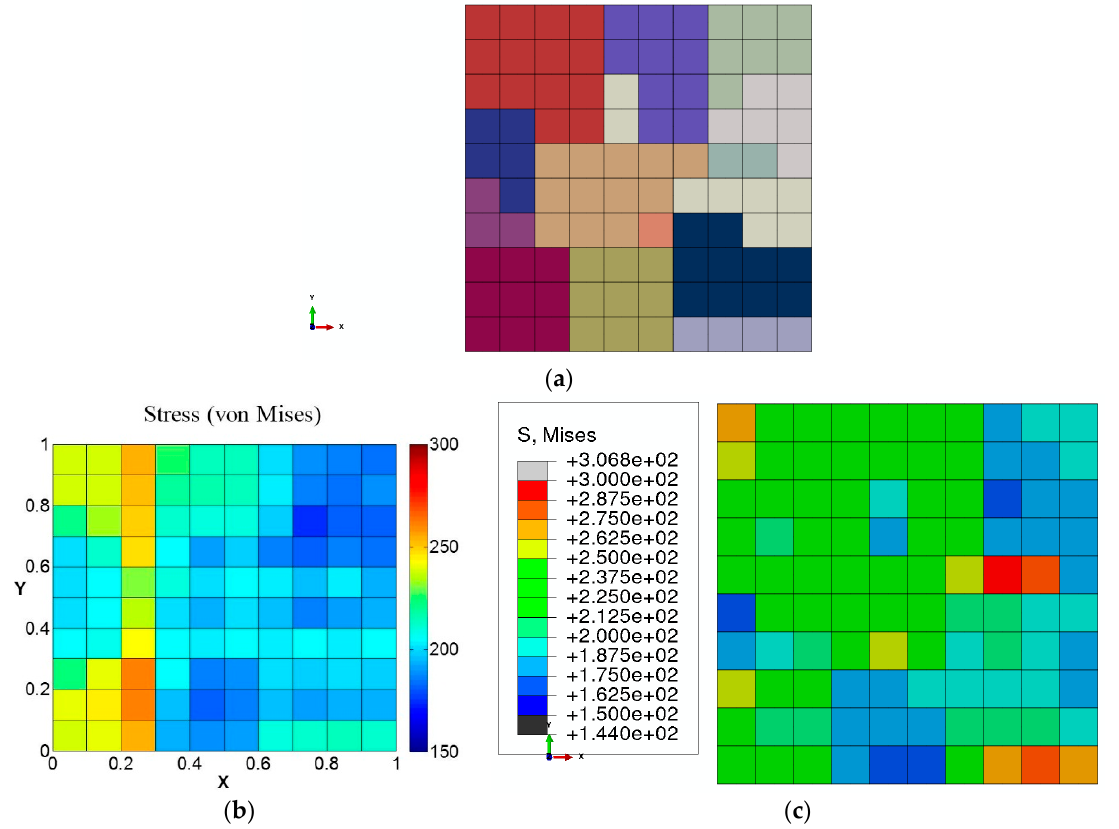
Figure 11. ( a ) Material distribution on the studied cross-section; ( b ) von Mises stress obtained by GMC; ( c ) von Mises stress obtained by FEA. ( c ) von Mises stress obtained by